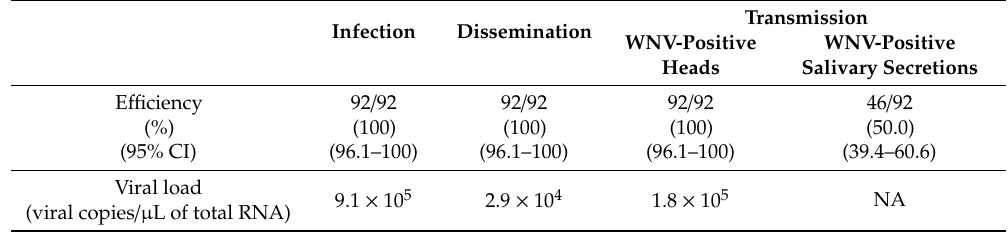
Table 2. Vector competence of Culex pipiens biotype pipiens after intrathoracic injection, used to challenge domestic geese with WNV lineage